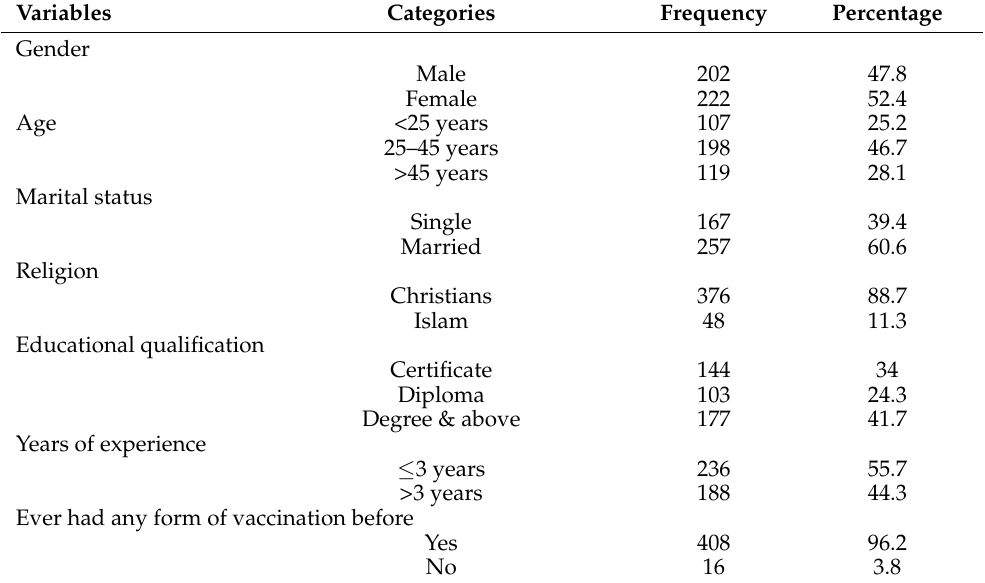
Table 1. Basic characteristics of respondents (N =